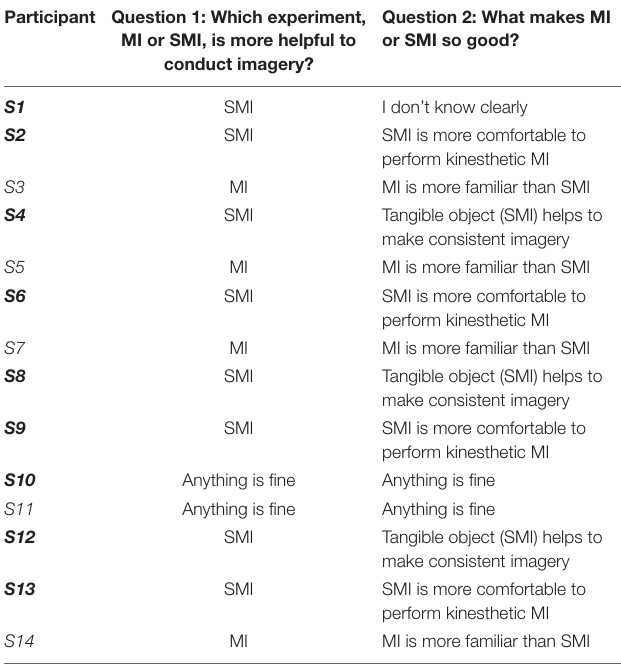
TABLE 3 | Results for a subjective interview related to feeling or experience between MI and SMI paradigms. Participant Question 1: Which experiment, MI or SMI, is more helpful to conduct